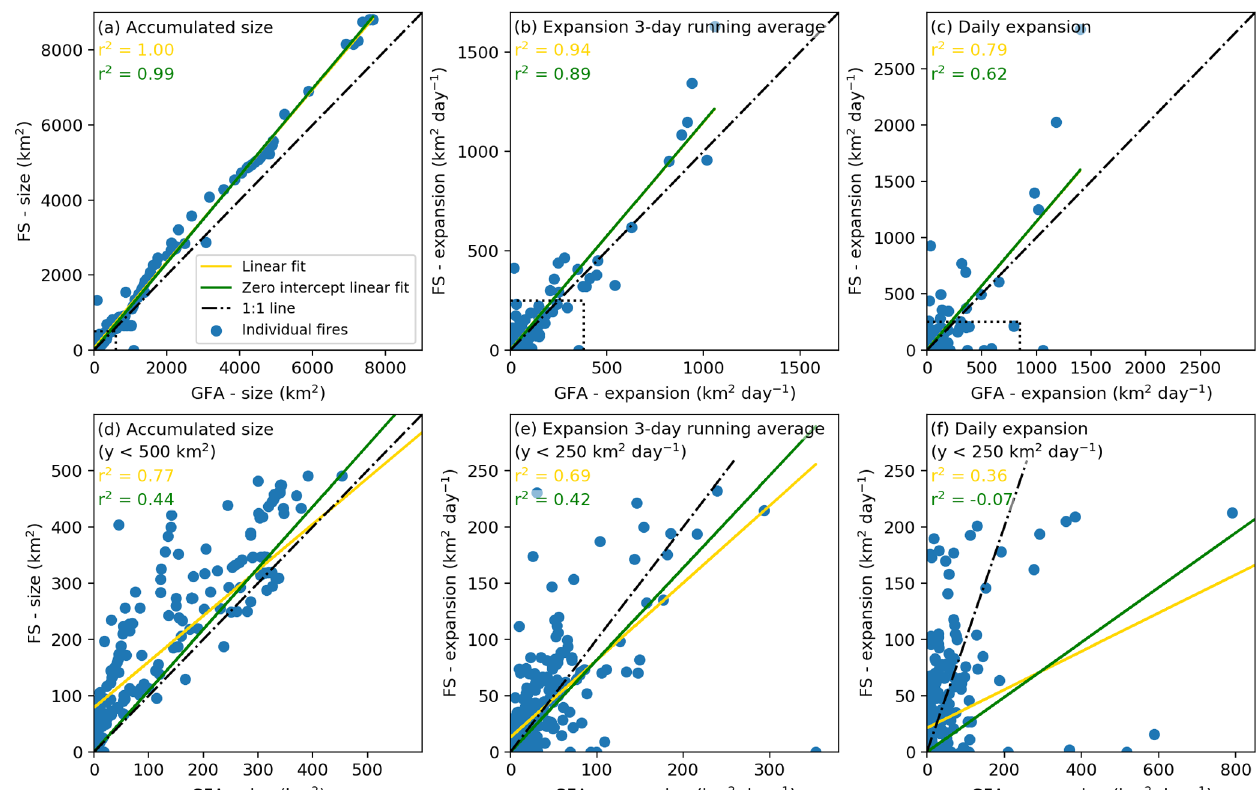
Figure B1. Comparison of daily Global Fire Atlas (GFA) and US Forest Service (FS) data for a selected number of well-characterized wildfires in the US. (a) The accumulated daily fire size (for all fires, N = 15) illustrates the ability of the Global Fire Atlas to reproduce individual large fire sizes at any specific day over the fire lifetime (each blue dot indicates the size of a specific fire on a specific day). (b) A 3d running average of the daily growth or “expansion” of each fire (km 2 d − 1 ) and (c) the daily expansion on each day of each fire. Panels (d) , (e) and (f) are like (a) , (b) and (c) but for US Forest Service fire sizes smaller than 500km 2 or expansion rates lower than 250km 2 d − 1 and corresponding Global Fire Atlas estimates (see dotted boxes in a , b and c